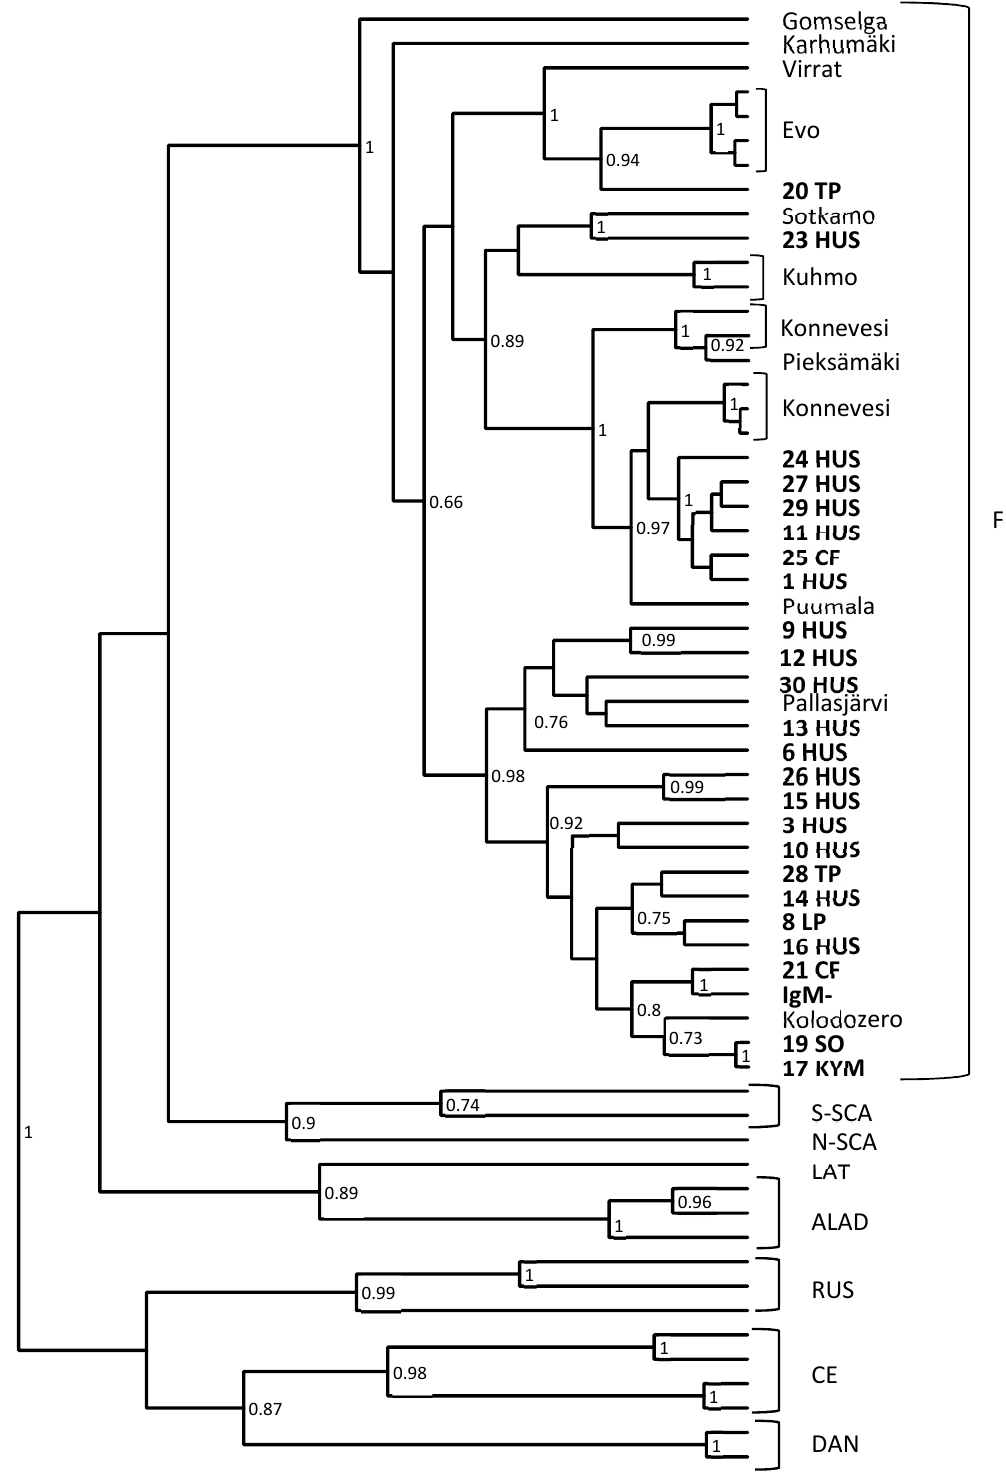
Figure 1. A phylogenetic tree based on partial PUUV S segment sequences. The sequences obtained in this study are shown as bold numbers. In addition to the Finnish (FIN) PUUV strains, we used representative sequences of the northern-Scandinavian (N-SCA), southern-Scandinavian (S-SCA), Latvian (LAT), Russian (RUS), Alpe-Adrian (ALAD) and central European (CE) lineages of PUUV.